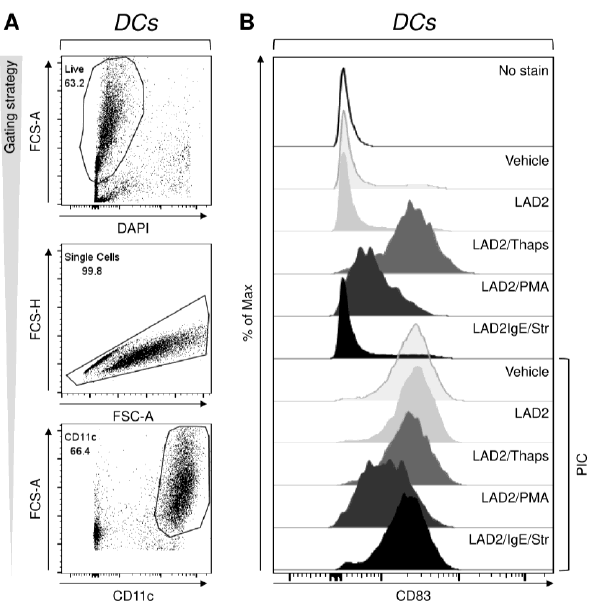
Figure 2. Impact of stimulated LAD2 MCs on the maturation of monocyte-derived dendritic cells (DCs) produced in the serum-containing medium. LAD2 MCs were, or were not (LAD2), stimulated with thapsigargin (LAD2/Thaps, 1 µM), PMA (LAD2/PMA, 50 ng/mL), or streptavidin (LAD2/IgE/Str, 10 µg/mL) for 30 min before the following co-culture with monocyte-derived immature(i)DCs. Monocyte-derived iDCs were produced in the serum-containing medium and matured for 20–24 h in F-bottom 96-well plate wells (0.2 × 10 6 of iDCs in 200 µL of culture medium) in the presence or absence of poly I:C (PIC, 25 µ g/mL) by no co-culture (Vehicle) or co-culture with differentially stimulated IgE-sensitized LAD2 MCs at a ratio 1:6 (LAD2 MCs:iDCs). The matured DCs were stained with the fluorescently labeled antibodies specific to the selected maturation markers and analyzed by flow cytometry. ( A ) The gating strategy for the analyses of the flow cytometry data to analyze DC maturation. ( B ) A histogram of the staining intensities of CD83 expression in DCs. The data ( A , B ) are representative of at least 4 donors, and the obtained data are evaluated in Figure